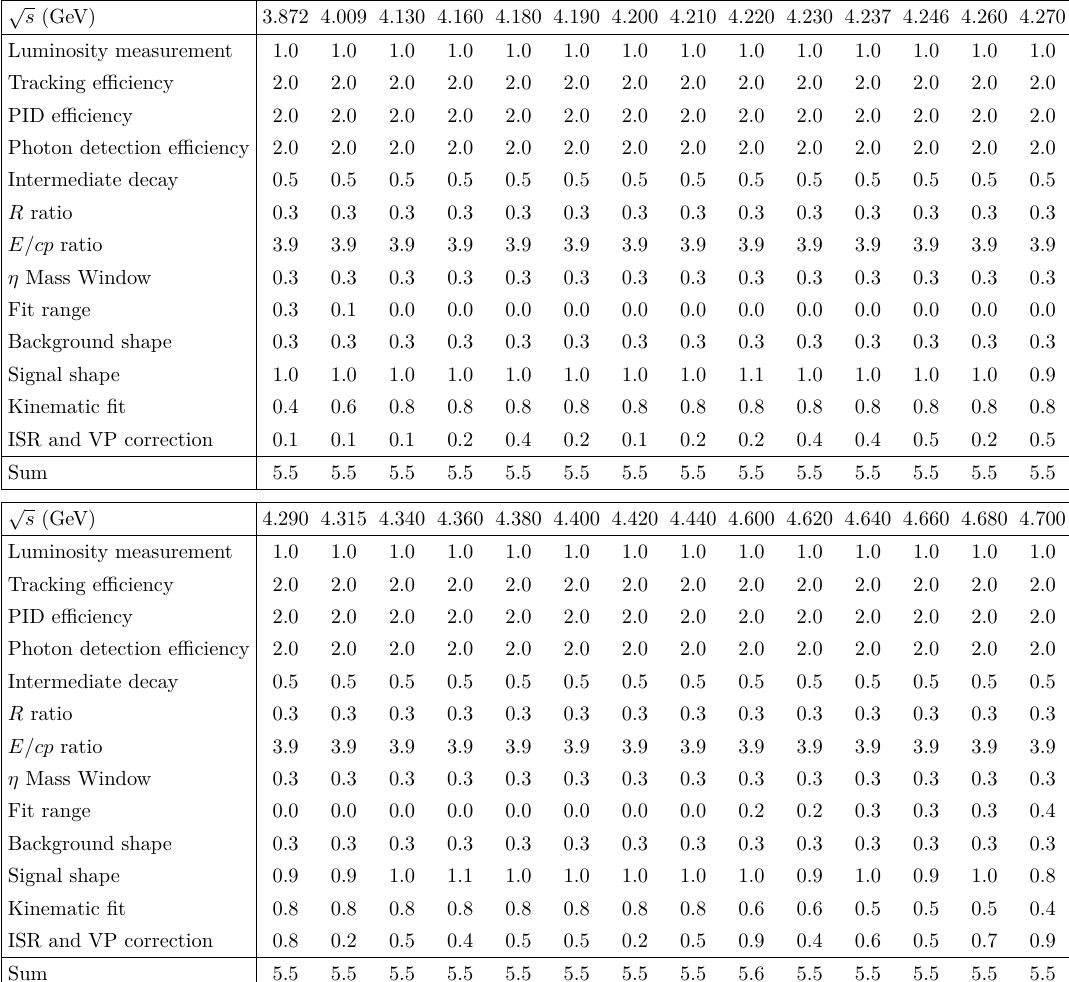
Table 5 . The relative systematic uncertainties (%) for the process e + e − → ηρ 0